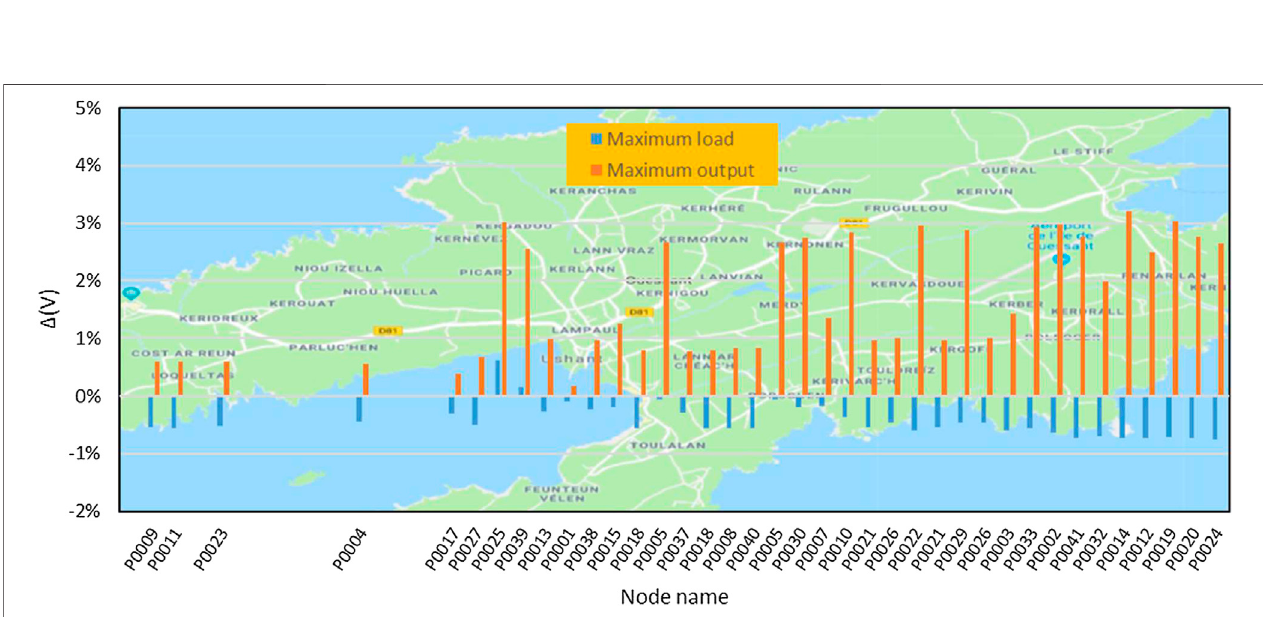
FIGURE 14 | Voltage drop at each load node under maximum load demand and maximum renewable energy generation power output (case 1).